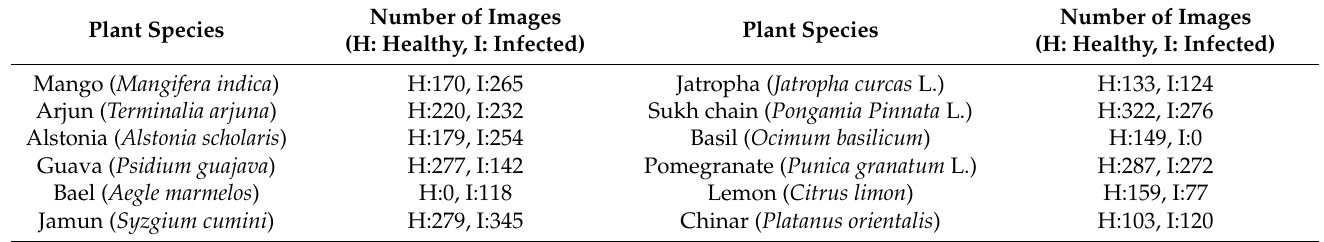
Table 2. The number of image samples present in the dataset.